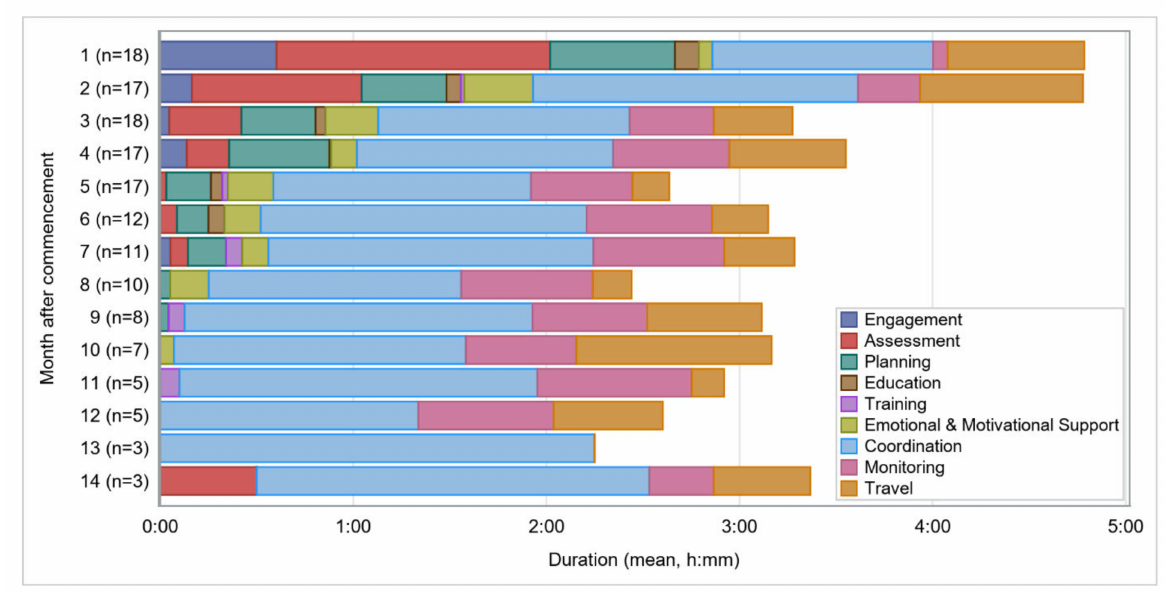
Figure 3. Service actions over time–Fast